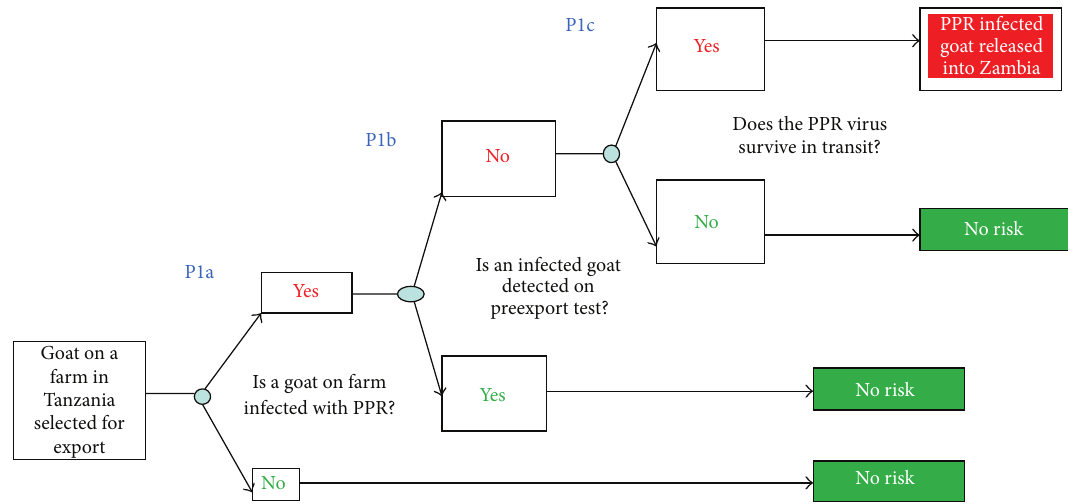
Figure 2: Scenario tree for PPR exposure to goats in Northern Zambia.